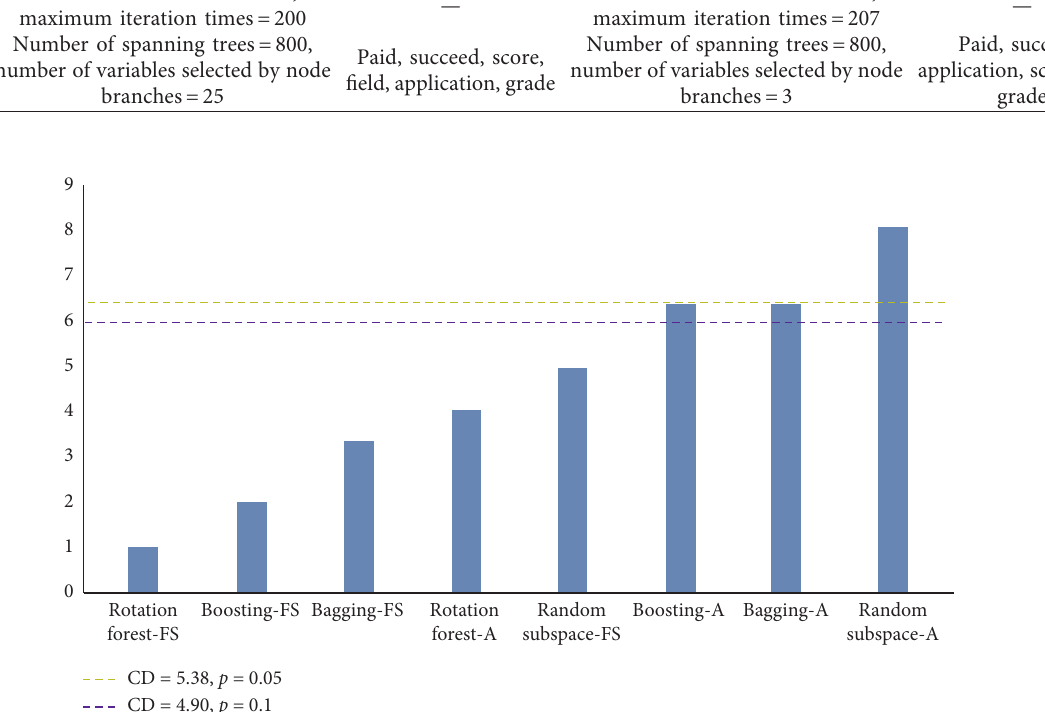
Figure 2: Friedman average